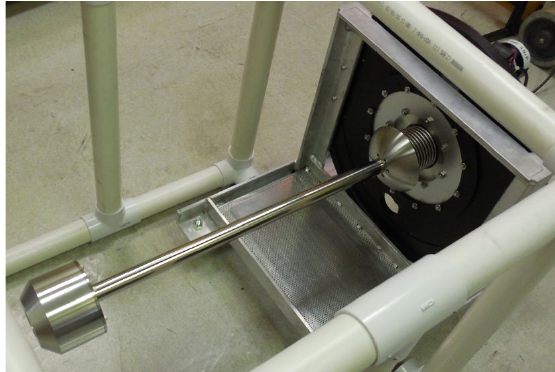
Fig 3. Life test of bellows-based reflector